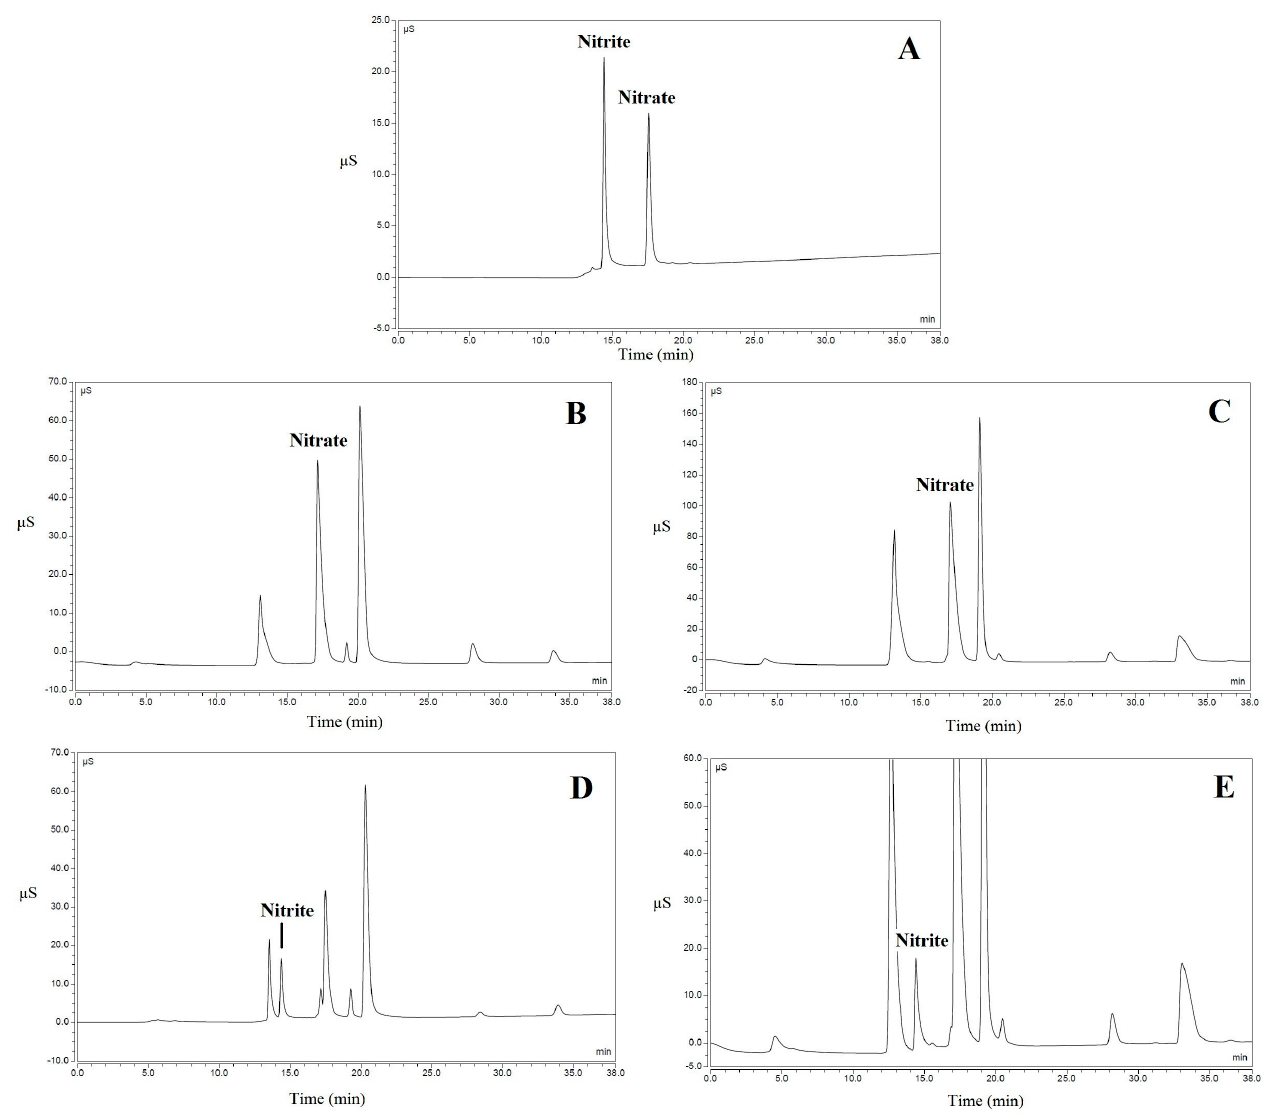
Figure 2. Chromatogram examples of HPIC analyses. ( A ): Nitrite and nitrate standard solution; ( B ): Fresh-cut Swiss chard sample with nitrate concentration of 2838.8 mg kg − 1 ; ( C ): Fresh-cut wild rocket sample with nitrate concentration of 7012.9 mg kg − 1 ; ( D ): Fresh-cut Swiss chard sample with nitrite concentration of 131.6 mg kg − 1 ; ( E ): Fresh-cut wild rocket sample with nitrite concentration of 206.6 mg kg − 1 .